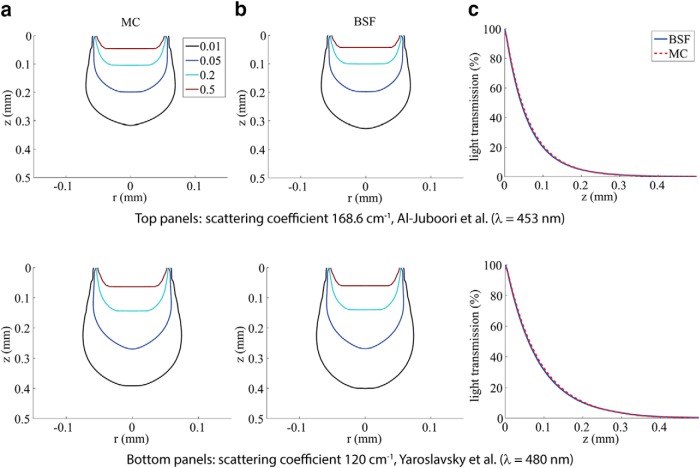
Comparisons of MC and BSF methods for two different tissue-scattering parameter settings: µs =168.6 cm−1 (top; from Al-Juboori et al. 2013) and µs =120 cm−1 (bottom; from Yaroslavsky et al. 2002). a, Contour maps of the light distribution in the tissue, created using the MC method. b, Contours created using the BSF method. The iso-intensity lines are at 50, 20, 5, and 1% of maximum. c, Light transmission curves along the z-axis.